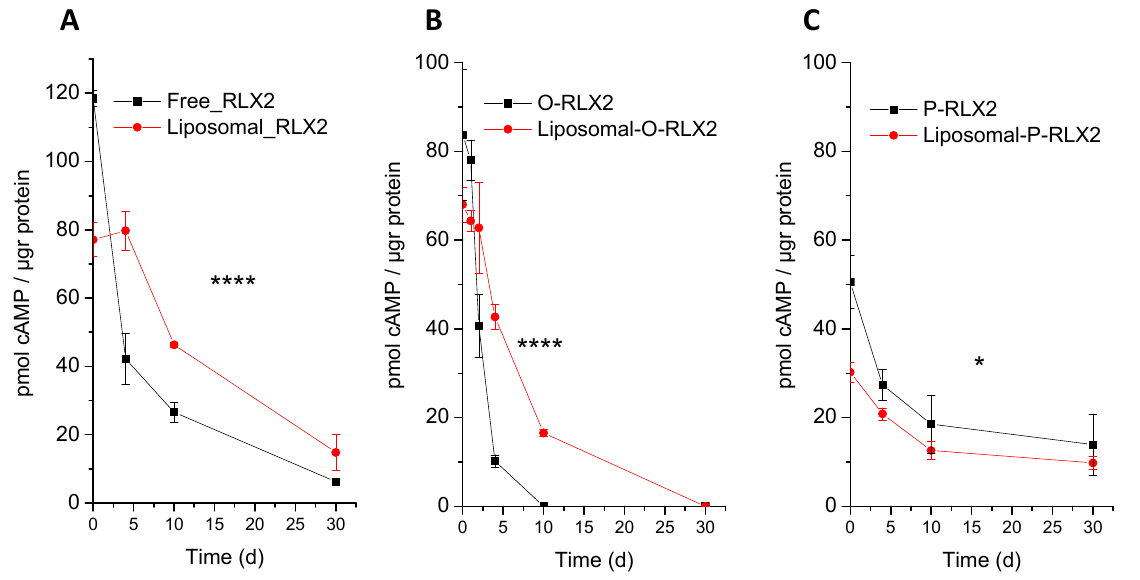
Figure 6. Bioactivity or cyclic adenosine monophosphate (cAMP) production, after treatment of cells